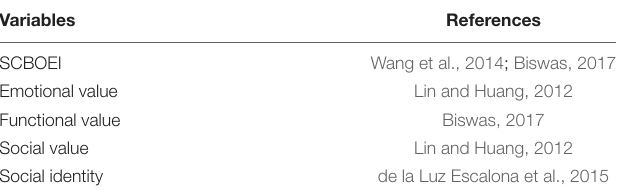
TABLE 3 | Source of variables measurement. TABLE 4 | Descriptive statistics of instruments used to explain sustainable consumption behavior in online education industry.